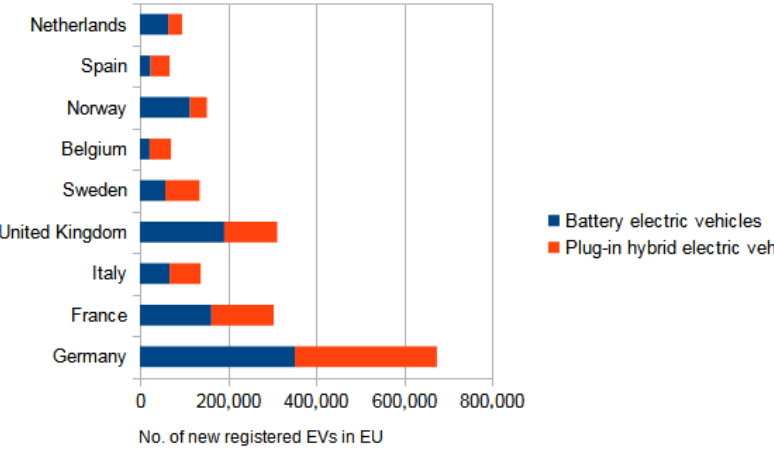
Figure 2. New EV registrations in the EU.